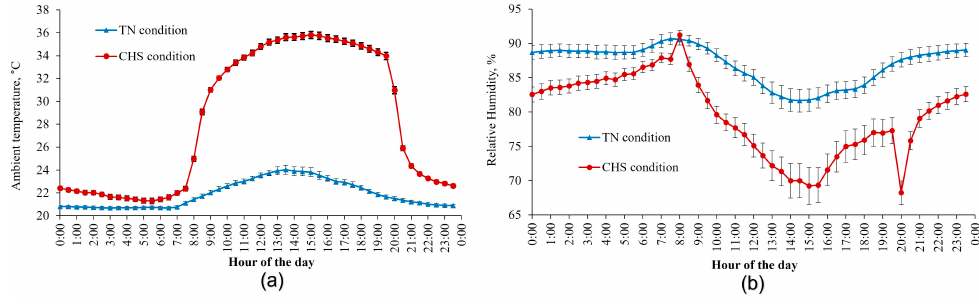
Figure 1. Average ambient temperature ( a ) and air relative humidity ( b ) were measured in thermoneutral (TN) and cyclic heat stress (CHS) conditions, with the aid of a thermohygrometer, at 30 min intervals, during the experimental days. Each vertical bar represents the standard error of the mean.